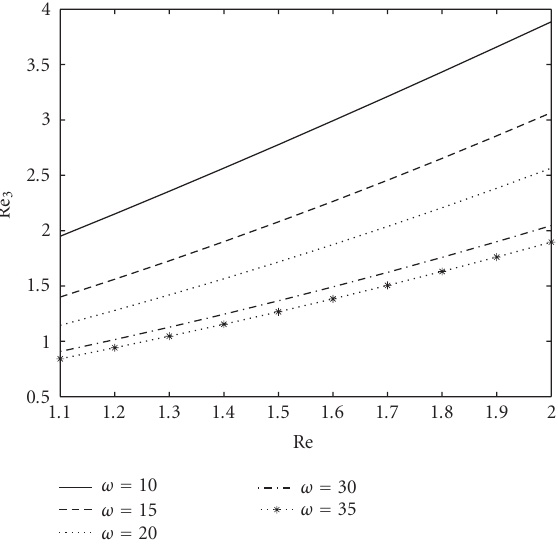
Figure 5.3. The amplitude Re 3 of Nusselt number for Pr = 0 . 72, S = 1 . 0, Ec = 10.